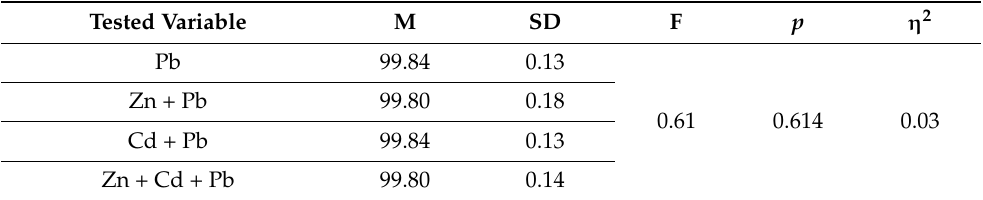
Table 13. Statistical analysis for sorption of Pb (% of removal) in regard to metal combination in the solution and the pyrolysis